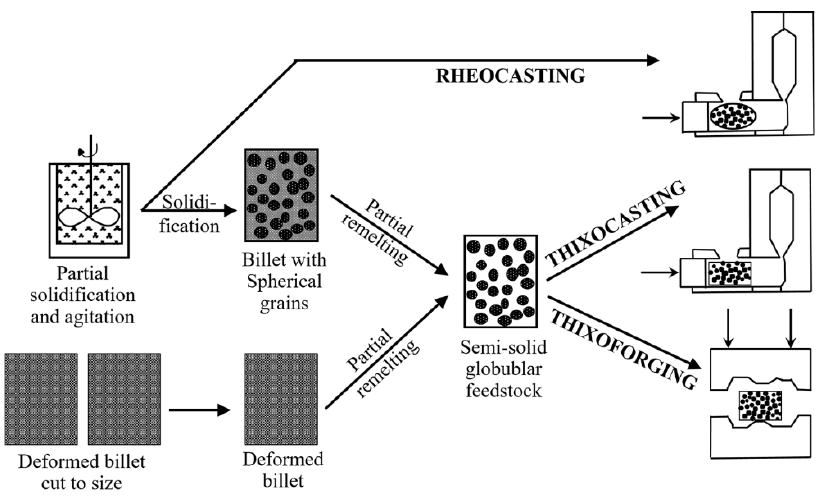
Figure 3. Schematic layout of different semi-solid process. Reprinted with permission from Ref. [26]. Copyright 2003 Springer Nature Customer Service Centre GmbH, Springer Nature.